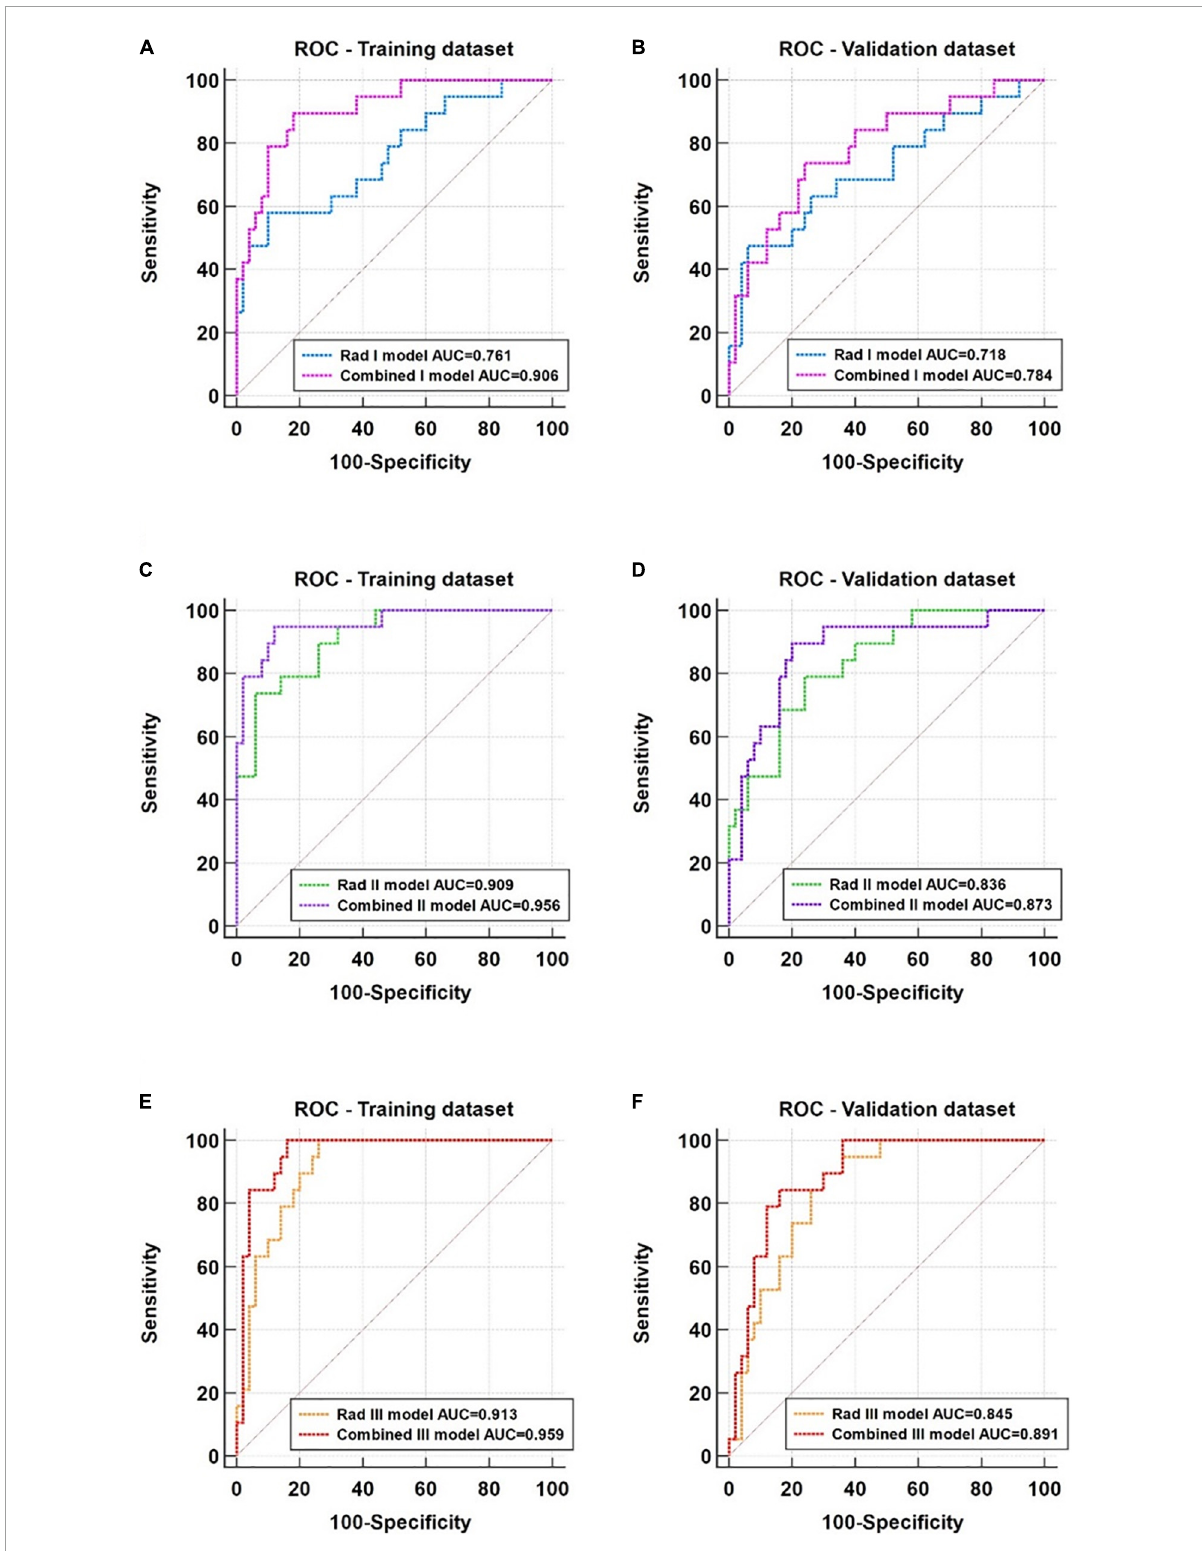
FIGURE6 ROC analysis of the radiomic models and corresponding combined models. (A,B) Comparison of the Rad I (basal level) model and the Combined I model in the training and validation datasets. (C,D) Comparison of the Rad II (middle level) model and the Combined II model in the training and validation datasets. (E,F) Comparison of the Rad III (apical) model and the Combined III model in the training and validation